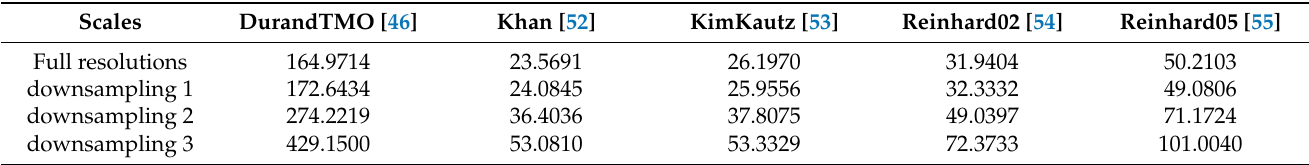
Table 3. Average EoG values of five TMOs at four